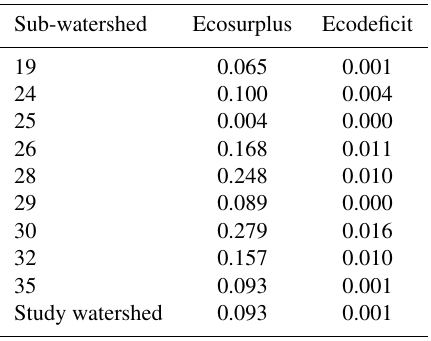
Table 5. Ecosurplus and ecodeficit values for the burned sub- watersheds as well as for the entire study watershed.